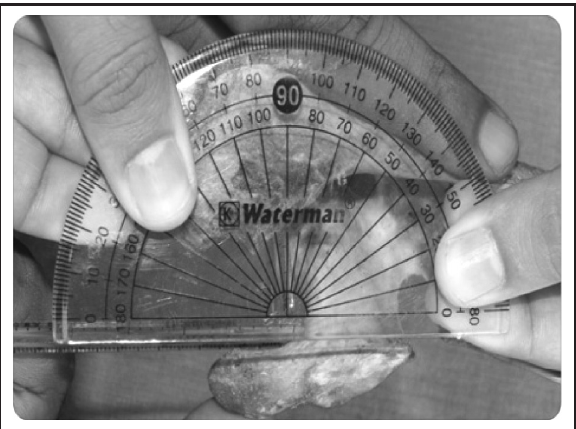
Figure 7. Measurement of Coracoid Angle.